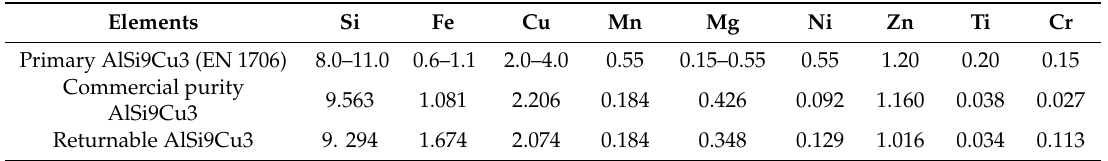
Table 1. Chemical composition of primary AlSi9Cu3 by standard, secondary alloy and returnable materials of AlSi9Cu3 alloy (wt.%).